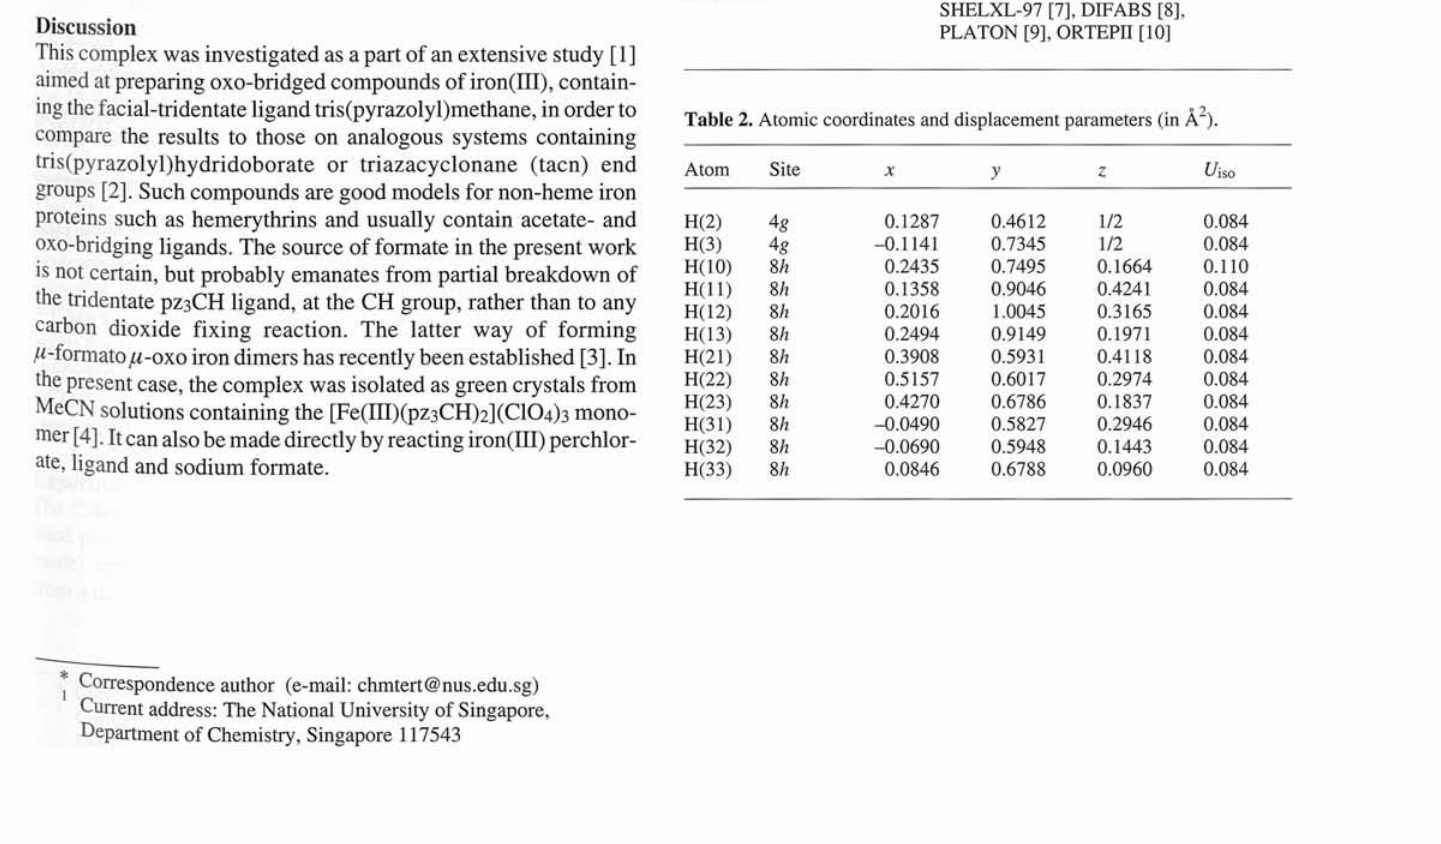
Table 1. Data collection and handling.